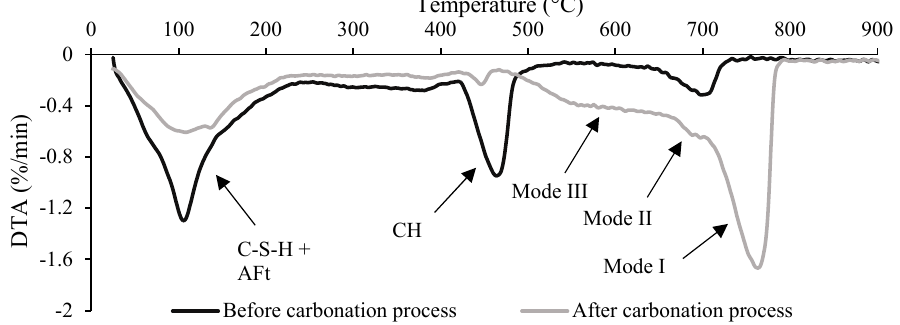
Figure 4. DTA results before and after the carbonation process.